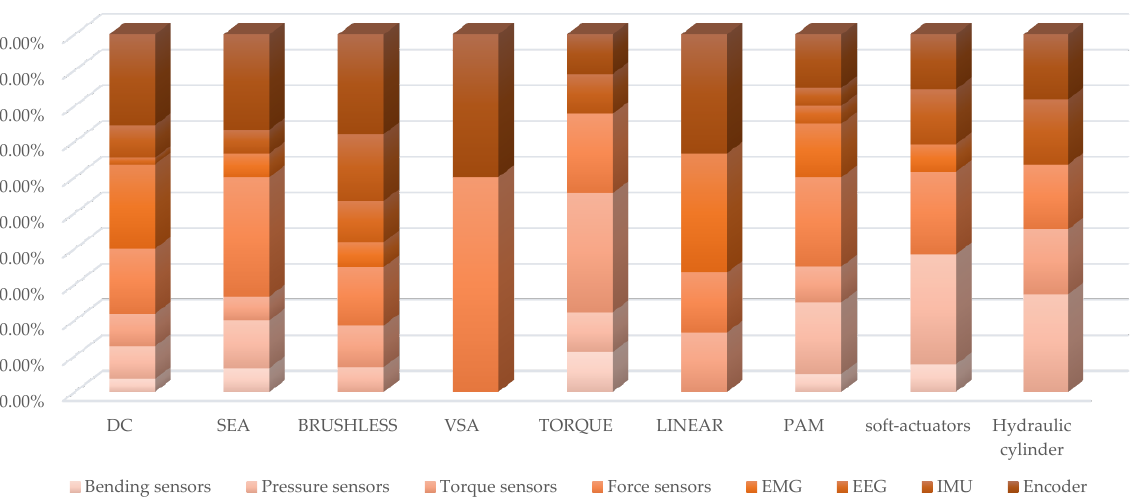
Figure 27. The distribution of the sensor type with the different actuator types. Encoders have an important and almost equal presence with brushed DC motors (26%), SEAs (27%) and brushless motors (28%). Force sensors are widely used with SEAs (33%) and VSAs (60%) and with fluidic actuators. Pressure sensors are highly used with soft actuators (31%), PAMs (20%) and hydraulic cylinders (27%).